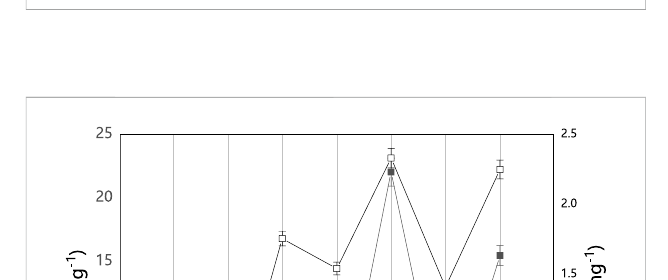
FIGURE 2 Effect of ARTP implantation time on T-SOD activities of M. thermophila. T-SOD activity was determined according to the xanthine oxidase method. Reagents preparation and results determination were carried out according to kit requirements. All experiments were carried out four times (biological duplicates and technical duplicates) and mean values presented with standard deviations.